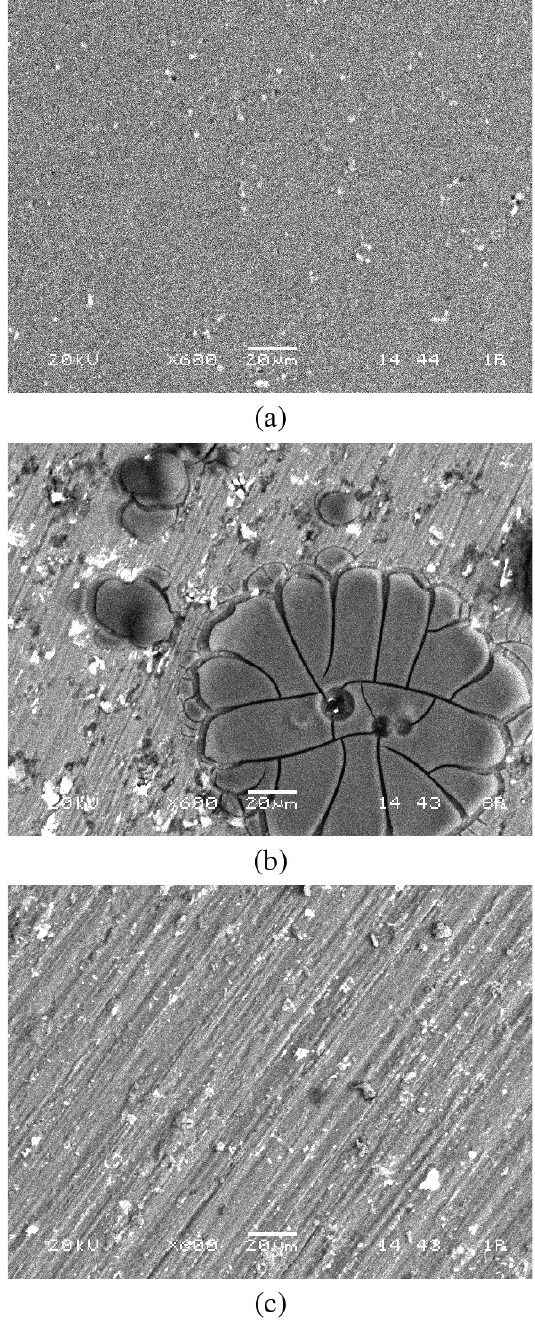
Figure 9. SEM micrographs of Al-2007 alloy surface: (a) before immersion; (b) after 2 h of immersion at 20 °C in 3.5% NaCl solution; (c) after 2 h of immersion at 20 °C in 3.5% NaCl with 1500 ppm mad